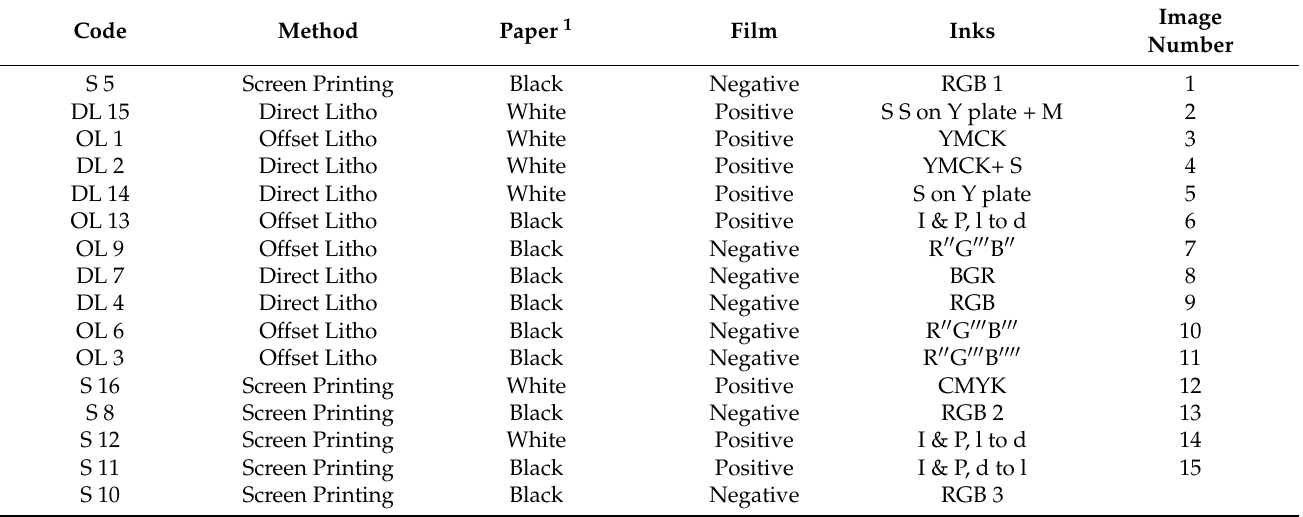
Figure 4. a*, b* coordinates of the inks from Table 6 in the color space CIEL*a*b. The number in each label is the mean luminosity. Table 6. Printed outcomes. S = Solar Gold. Symbol ‘ indicates the number of passes. I & P means Iriodin™ and Pyrisma™ specialty